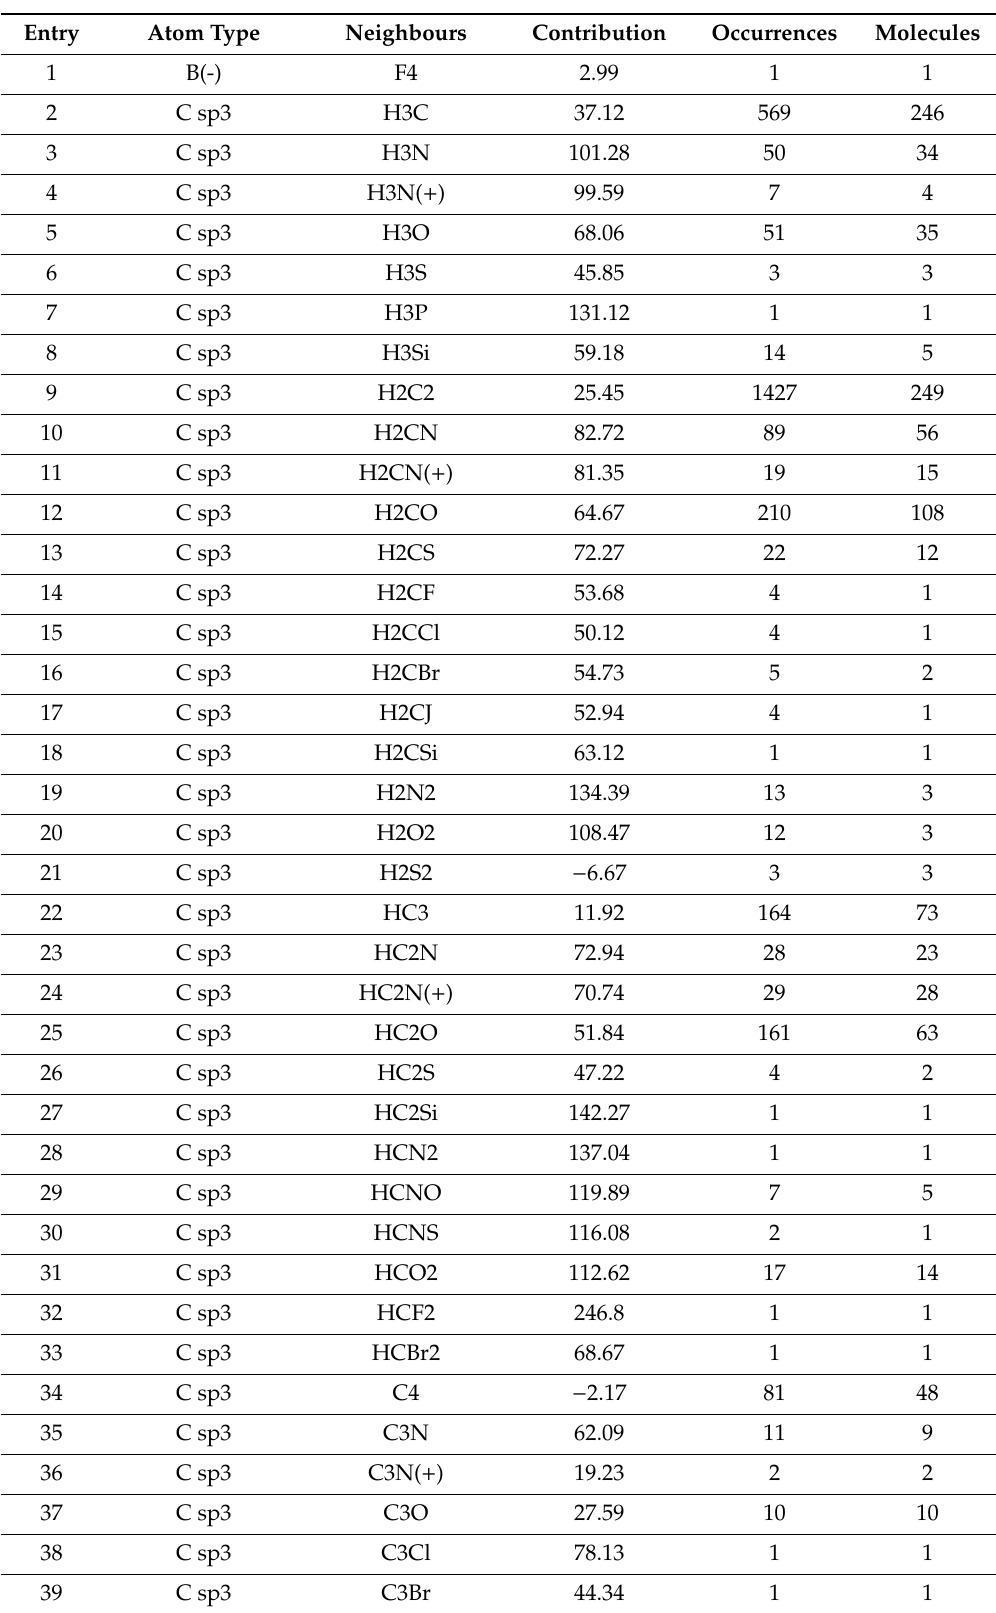
Table 7. Atom groups and their contributions for the heat-capacity calculation of